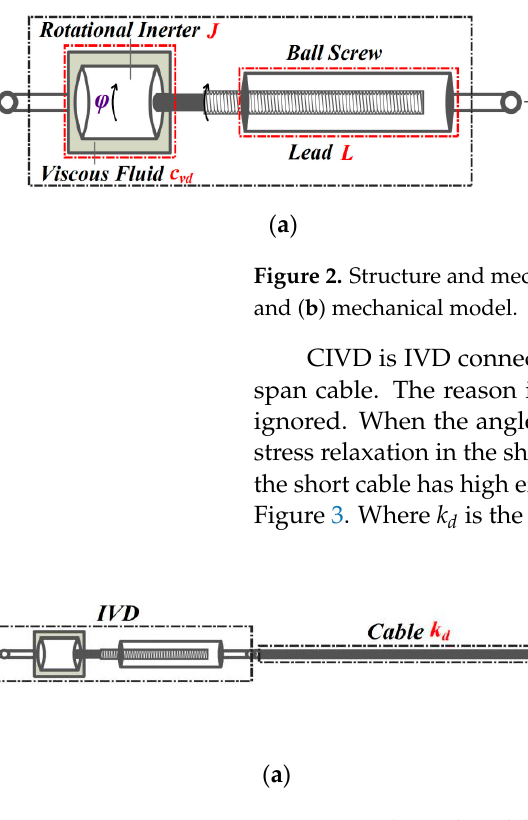
Figure 2. Structure and mechanical model of an inerter viscous damper (IVD): ( a ) Structure of IVD; and ( b ) mechanical model.